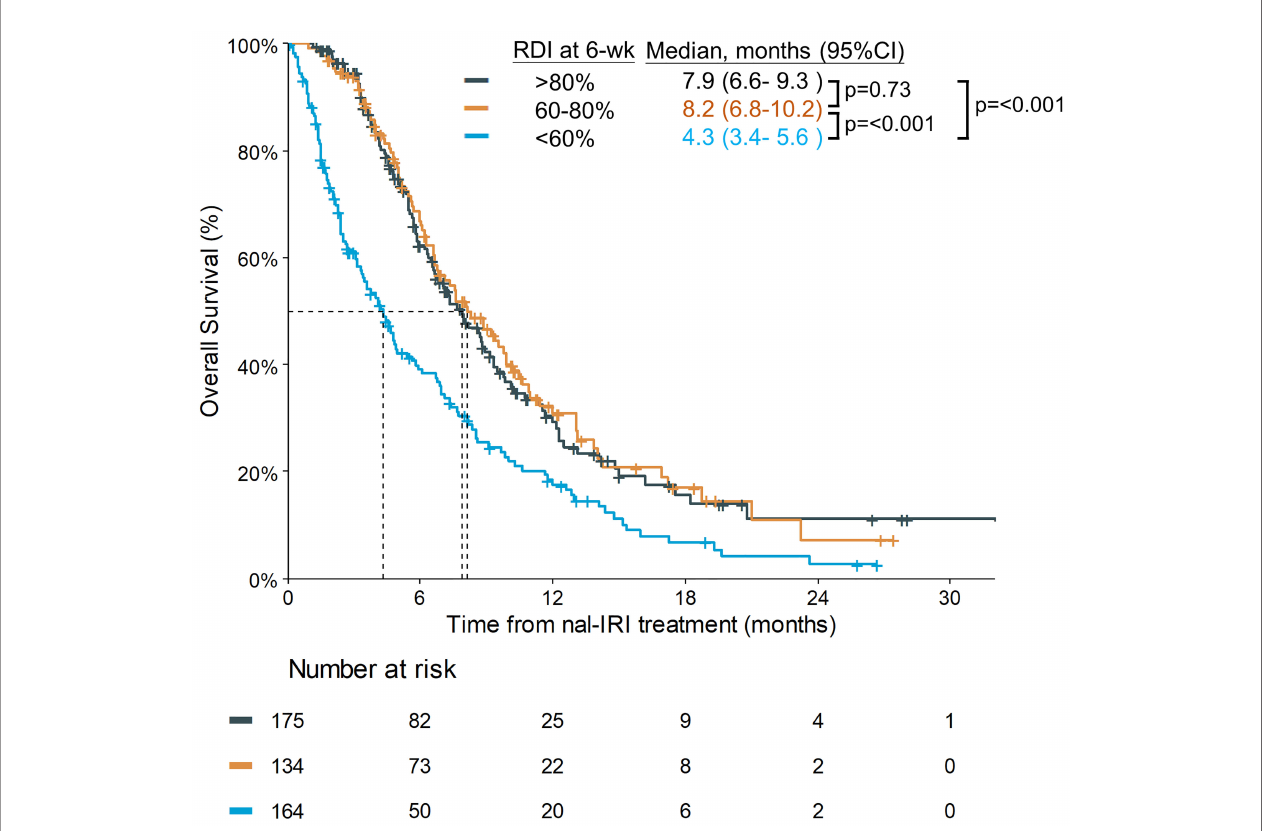
FIGURE 2 | Overall survival (OS) of different cumulative dose groups. RDI, relative dose